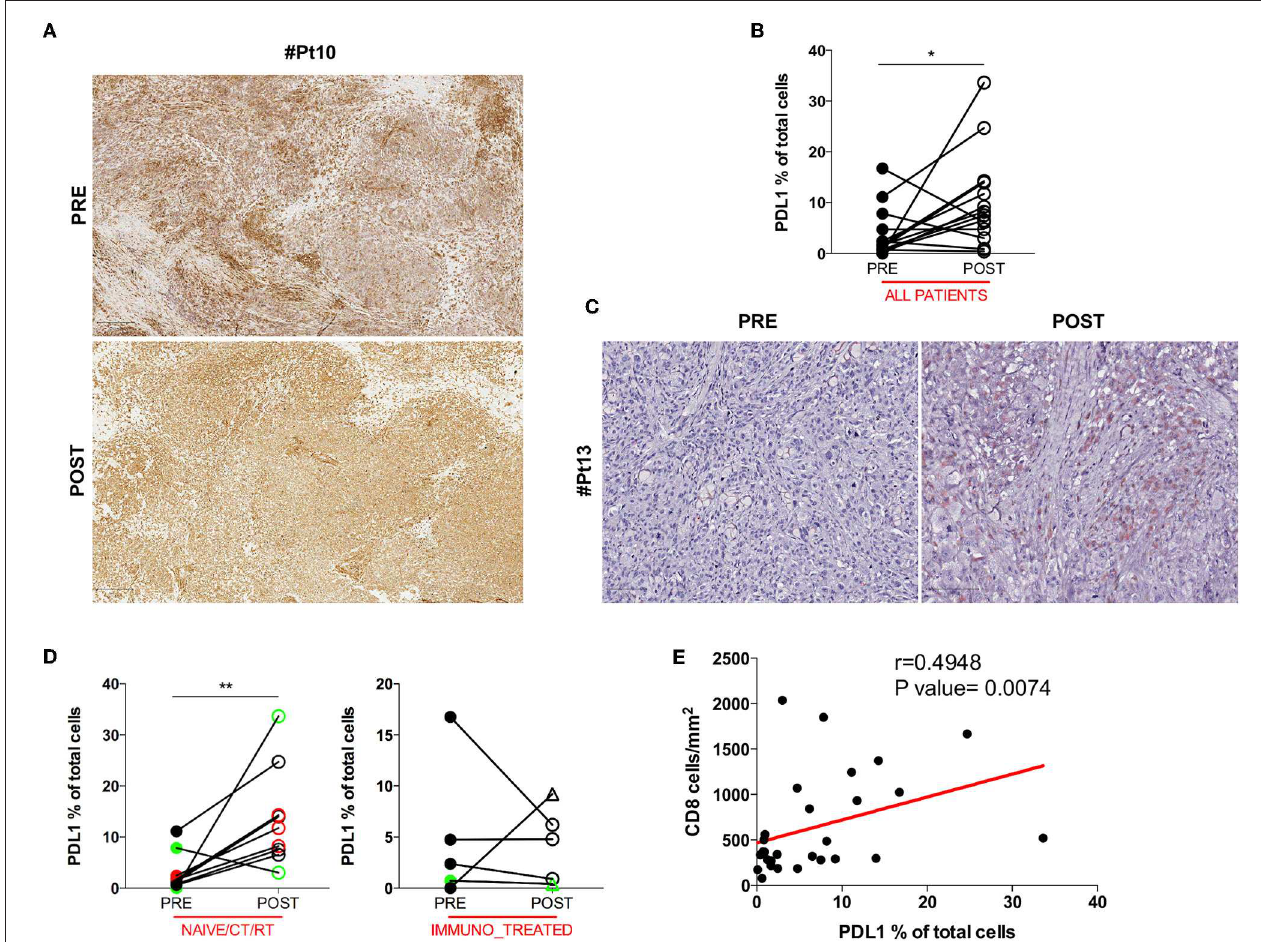
FIGURE 2 | HLA class I and PDL1 expression in serial tumor biopsies from DC vaccine treated patients. The pattern of HLA class I expression by melanoma cells is shown in matched pre- and post-therapy lesions for one representative patient (Pt#10). Scale bars, 250 µ m (A) . Differences in intratumoral PDL1 expression are illustrated in the graph as the percentage of PDL1 expressing cells on the total cell number ( n = 14, * p = 0.0353) (B) . A representative example of the staining is shown (Pt#13). Scale bars, 100 µ m (C) . PDL1 expression distribution in matched samples within the naïve/CT/RT cohort and the immuno_treated cohort is reported in right and left graphs ( n = 9, ** p = 0.0078 and n = 5, p = 0.6250), respectively. CR and PR Patients are displayed in green, SD in black, and PD in red. Open circles denote on-treatment samples, open triangles post-treatment ones (D) . A positive correlation was found between CD8 and PDL1 expression (Spearman r = 0.4948, p = 0.0074) (E) . Statistical comparisons are based on the non-parametric two-tailed Wilcoxon signed-rank test. Only values statistically significant are reported: * p < 0.05 and ** p <